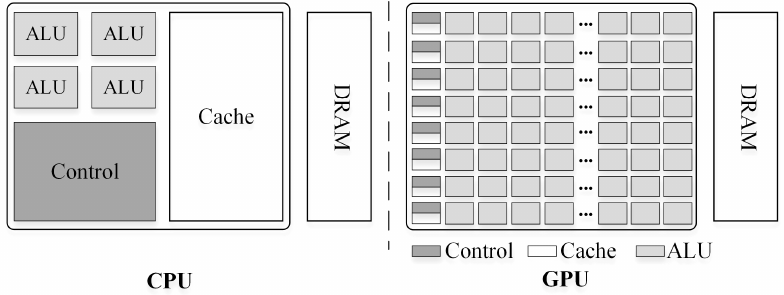
Figure 1. Different architectures of a CPU and GPU.